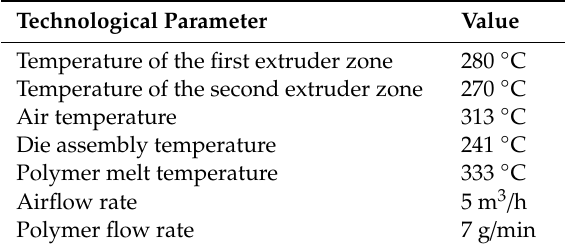
Table 3. Technological parameters of the melt-blown process.